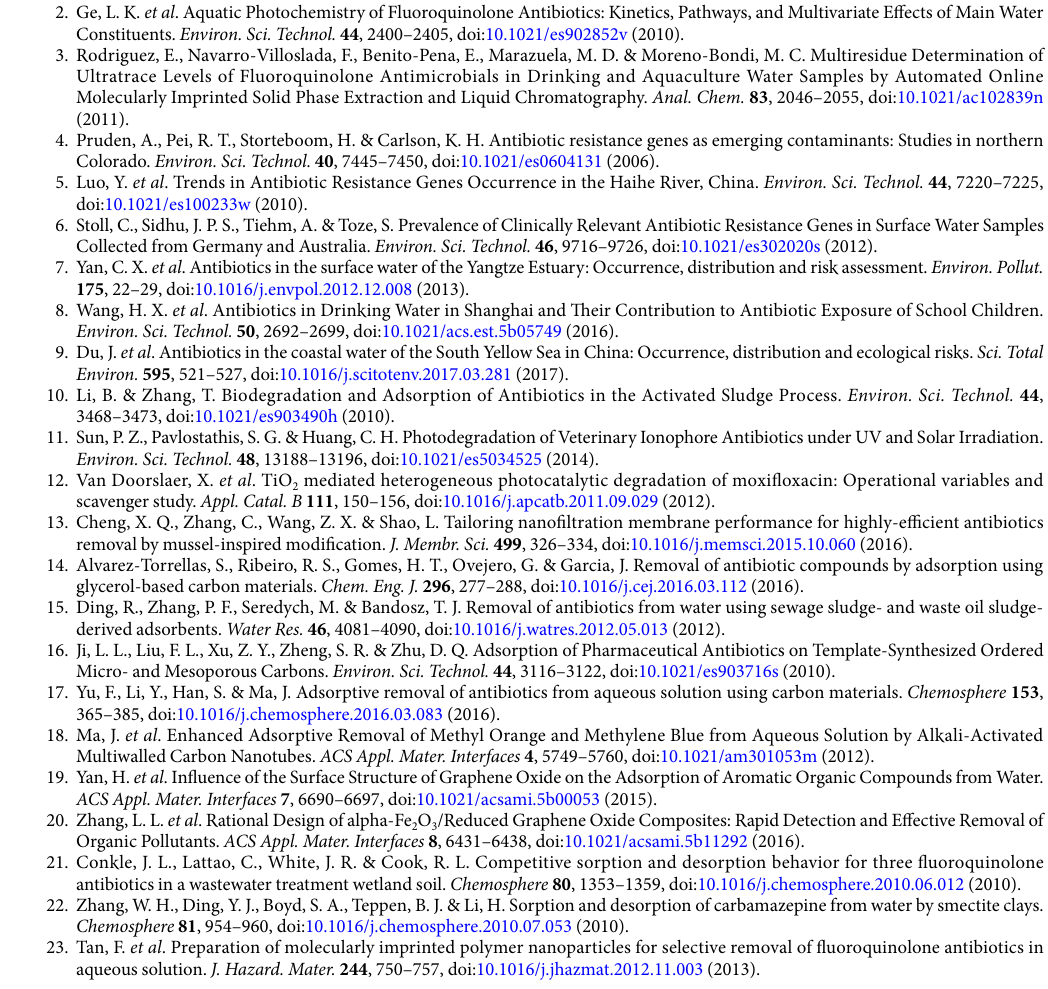
8 Scientific RepoRts | 7: 5735 | DOI:10.1038/s41598-017-06303-y